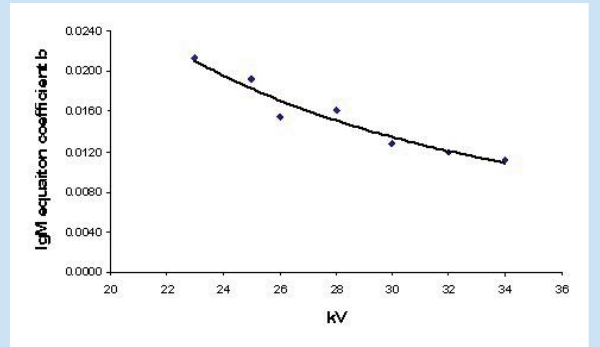
Fig. 2. AGD v. lgM on the plate at different kVp values.